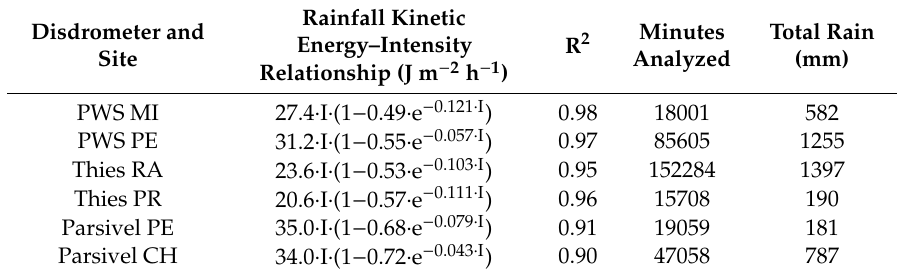
Figure 3. Rainfall kinetic energy–intensity relationships for each disdrometer and site with both unfiltered and filtered data points shown. The black line is the developed exponential rainfall kinetic energy–intensity relationship. Notes: MI = Mistelbach; PE = Petzenkirchen; RA = Rauchenwarth; PR = Prague; and CH = Christchurch. Table 4. Specifics of data from each measurement site and the developed rainfall kinetic energy–intensity relationships after